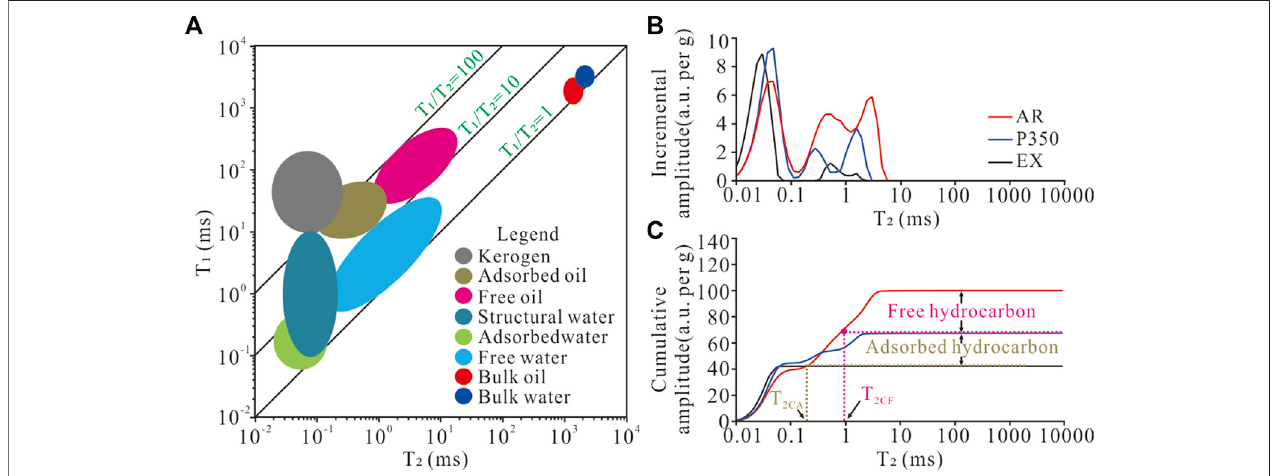
FIGURE9| DeterminationofshalemovableoilandadsorbedoilaccordingtoT 1 -T 2 spectrum(modi fi edfromLiJ.B.etal.,2020a).ARistheoriginalsample,P350is the sample after pyrolysis to 350 ° C, EX is the sample after solvent extraction, T 2CF is the T 2 cut-off value of movable oil, T 2CA is the T 2 cut-off value of adsorbed oil.